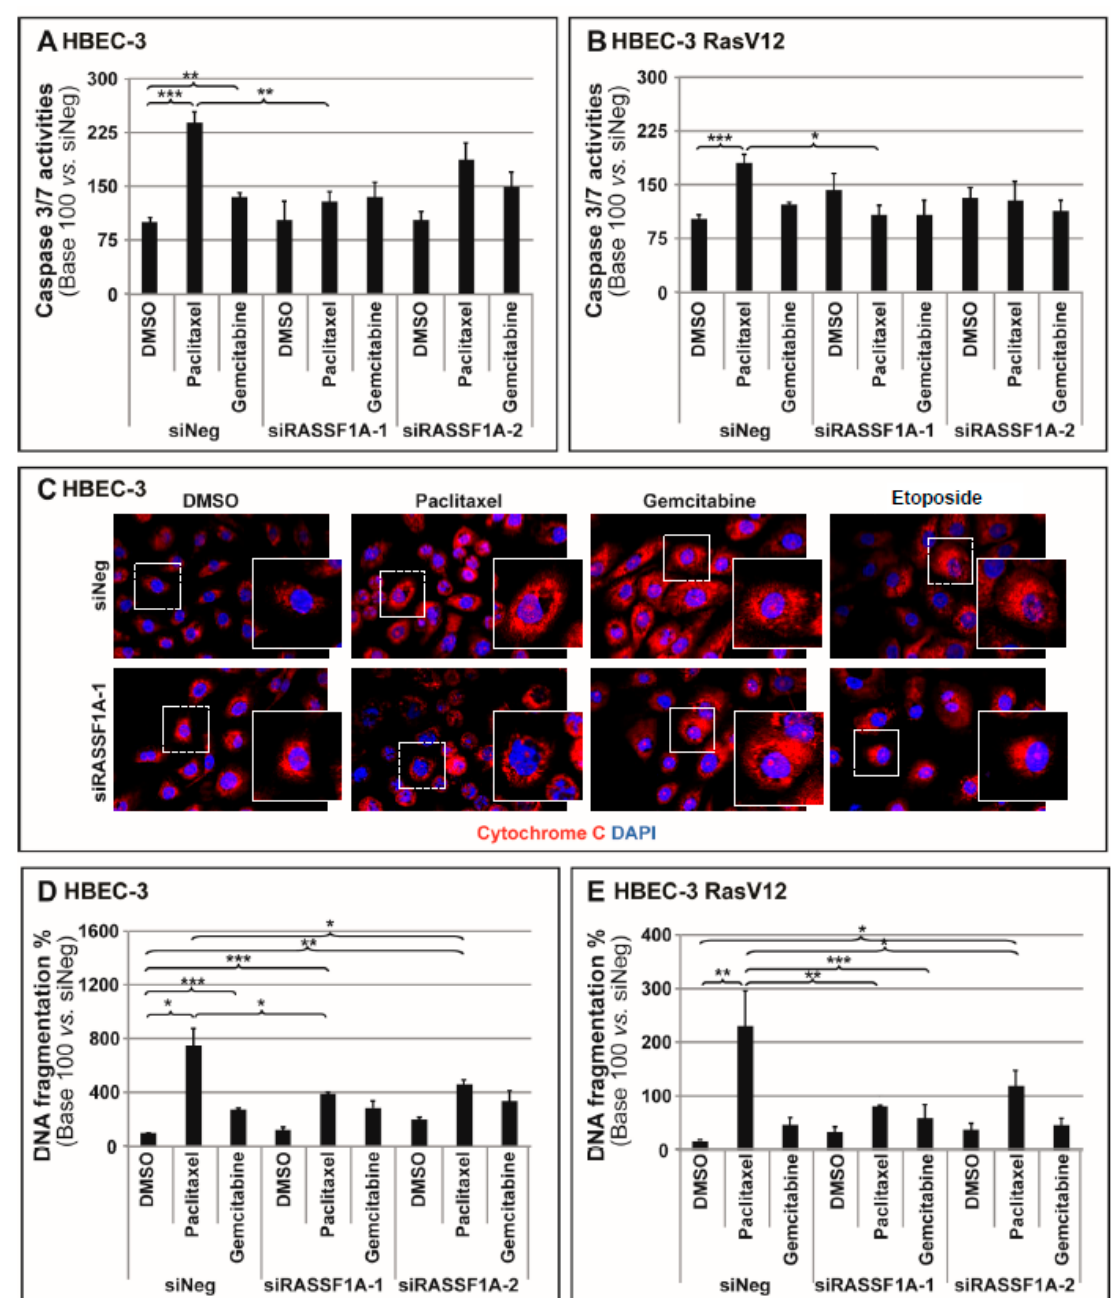
Figure 1. RASSF1A depletion suppresses cell sensitivity to drug-induced apoptosis. HBEC-3 cells were transfected with siNeg or siRASSF1A. The 24-h post-transfection cells were treated for a further 24 h with paclitaxel (10 nM) or gemcitabine (250 nM). ( A , B ) The e ff ect of RASSF1A depletion on caspase-3 / 7 activity was measured by Caspase-Glo ® 3 / 7 Assay kit in ( A ) HBEC-3 and ( B ) HBEC-RasV12 cells undergoing apoptosis using paclitaxel or gemcitabine treatment. ( C ) The e ff ects of RASSF1A depletion on cytochrome C expression were observed by immunofluorescence in HBEC-3 cells undergoing apoptosis induced by paclitaxel or gemcitabine treatment. Magnification: objective × 60. ( D , E ) The e ff ects of RASSF1A depletion on DNA fragmentation were measured in ( D ) HBEC-3 and ( E ) HBEC-RasV12 cells undergoing apoptosis induced by paclitaxel or gemcitabine treatment. The data are expressed as the mean ± SEM from three individual experiments. The statistical significance was determined by a Student’s t –test: * p < 0.05; ** p < 0.01; *** p < 0.001.